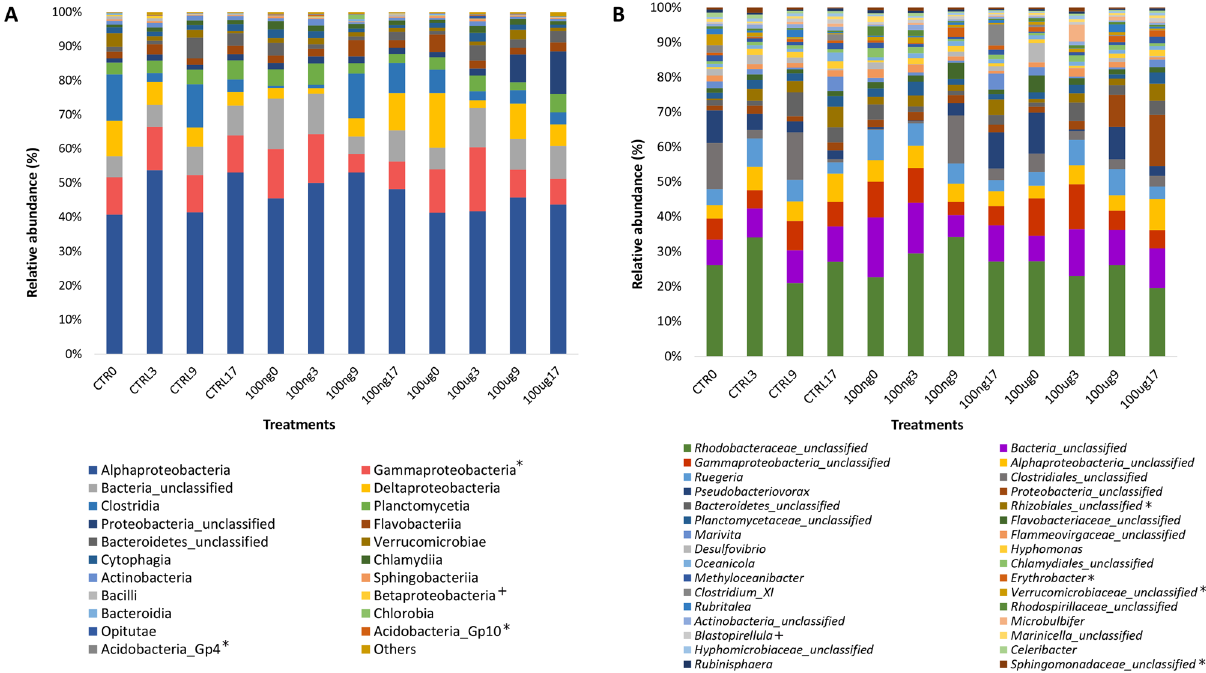
Figure 3. ( A ) Taxonomic classification and relative abundance of the bacterial classes from Mussismilia harttii treatments: control (without EE2), 100 ng L −1 and 100 µg L −1 of EE2 (n = 4). + indicates significant difference between times (days; T3 and T9) and treatment control with 100 µg L −1 of EE2; *indicates significant difference between times (days; T3, T9 and T17 in Gammaproteobacteria) and T3 and T17 in Acidobacteria. ( B ) Taxonomic classification and relative abundance of bacterial genera from M. harttii treatments: control (without EE2), 100 ng L −1 and 100 µg L −1 of EE2 (n = 4). + indicates significant difference between times (days; T0 and T17) and interaction among factors; *indicates significant difference between times. The third day (T3) was significantly different in Sphingomonadaceae_unclassified; times T0 and T17 in Verrucomicrobiaceae_ unclassified; times T3 and T9 in Erythrobacter ; and in Rhizobiales_unclassified, times T0 and T17 differed significantly, as did T9 and